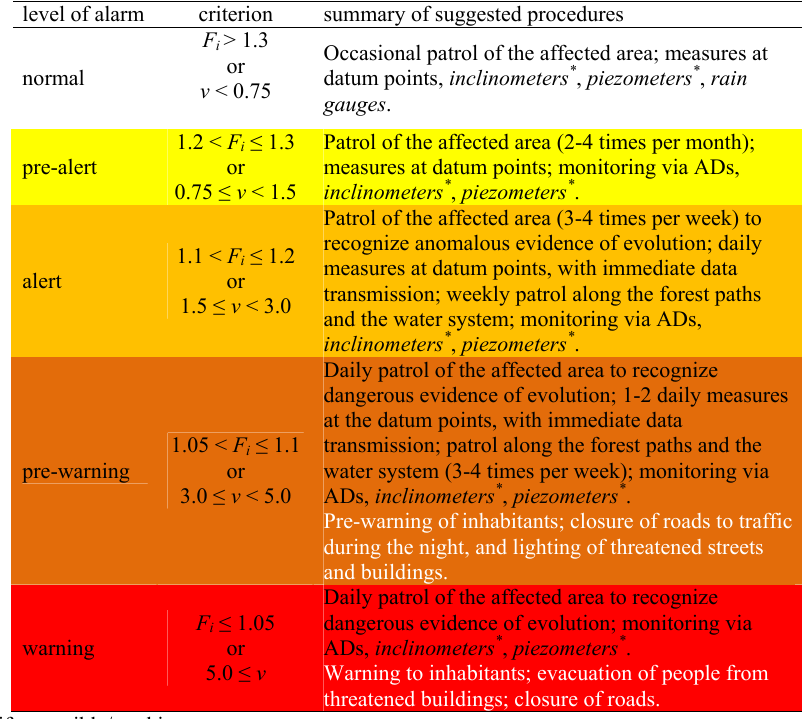
Table 2. Basic emergency procedures of landslide-risk management implemented at SBU (after Iovine et al., 2009, mod.), with refinements in the adopted criterion based on LEM analyses (cf. second column, and Table 3). Thresholds of maximum punctual velocity (v) are in cm/day. In Italics, instruments not available during the very-early phases of emergency in winter 2009. In white characters, mitigation measures suggested to the Authority of Civil